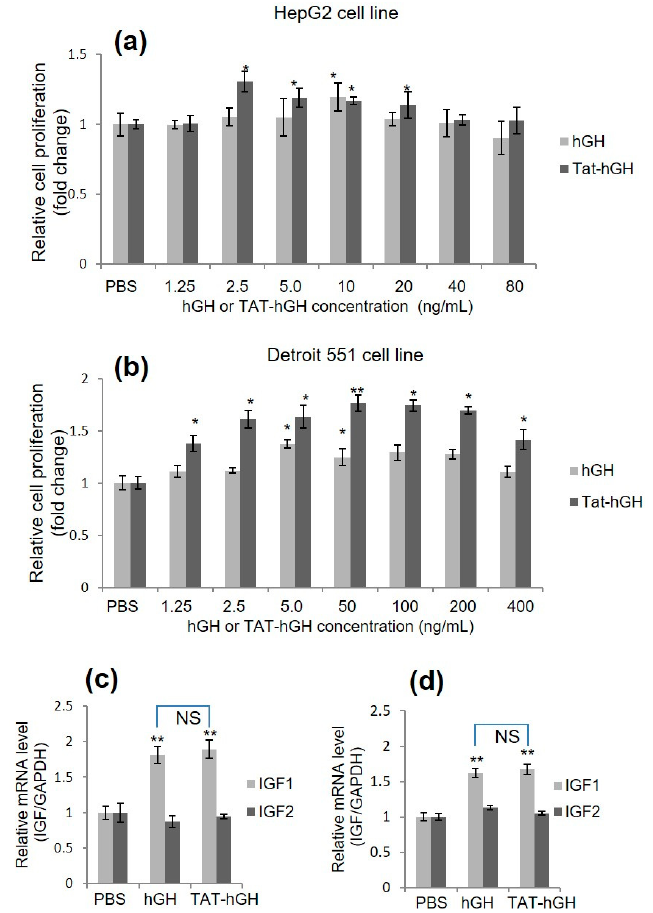
Figure 2. Relative cell proliferative activity and relative insulin-like growth factor (IGF) mRNA expression of human growth hormone (hGH) or TAT-conjugated hGH (TAT-hGH) in HepG2 and Detroit 551 cell lines over control. Cells were treated with hGH or TAT-hGH, and the relative cell proliferation and IGF mRNA expression were measured and normalized to control. ( a ) Proliferative activity in HepG2 cell line. ( b ) Proliferative activity in Detroit 551 cell line. ( c ) Relative IGF expression following treatment with hGH or TAT-hGH in HepG2 cell line. ( d ) Relative IGF expression following treatment with hGH or TAT-hGH in Detroit 551 cell line. Results are presented as the mean ± standard deviation ( n = 3). NS indicates no significance; * indicates p < 0.05 versus the control (vehicle); ** indicates p < 0.01 versus the control (vehicle).